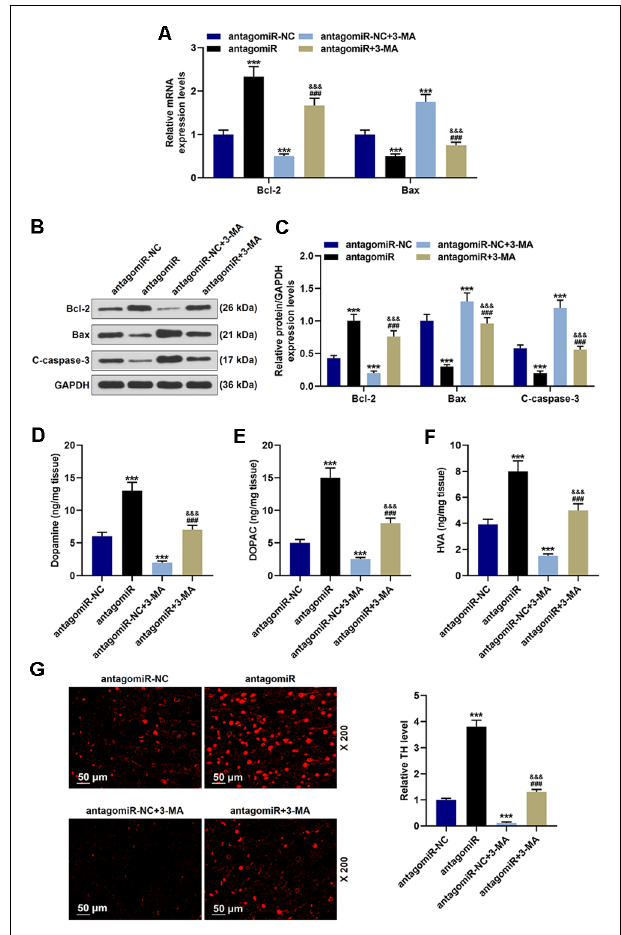
FIGURE 3 | Effect of miR-30c-5p on behavioral symptoms and oxidative stress level in PD mice through autophagy. (A–C) Western blot analysis of autophagy-related proteins (p62, LC3 II, LC3 I, and ATG5) in brain tissues of mice. The ratio of LC3 II to LC3 I was calculated. (D) The time that the mice stayed on the rotarod was recorded. (E) The grip strength test was used to measure the forelimb grip strength. (F) The locomotor function was assessed using the footprinting test. (G–I) Oxidative stress-related factor levels, MDA, CAT, and SOD were detected in mice. ** p < 0.01, *** p < 0.001 vs. antagomiR-NC. ### p < 0.001 vs. antagomiR-NC +3-MA. && p < 0.01, &&& p < 0.001 vs. antagomiR.